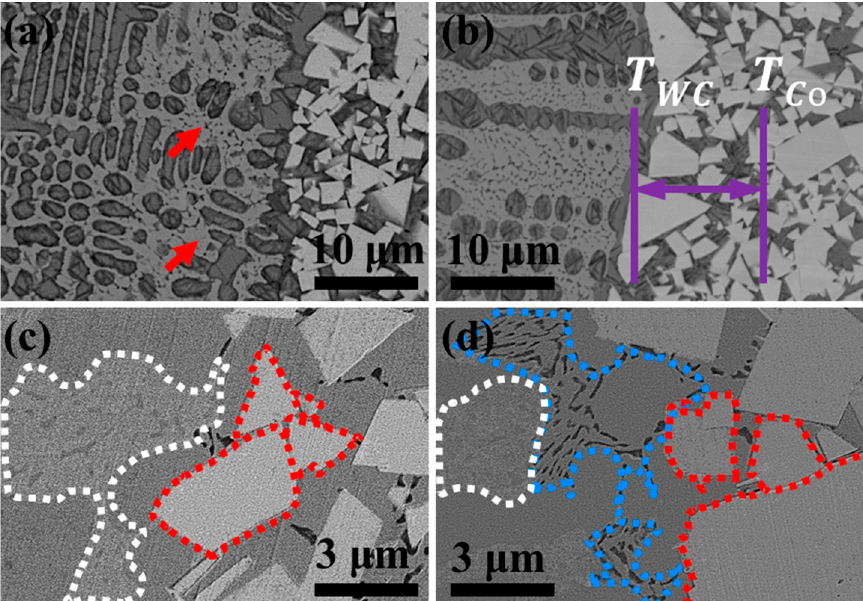
Figure 3. Laser welding of WC–Co cemented carbide and S45C carbon steel without filler metals. ( a ) Microstructures in a fusion boundary region. The red arrows show the mixed carbides. ( b ) The higher temperature border (T wc ) and lower temperature border (T Co ) of the fusion boundary region. ( c ), ( d ) Microstructures and grain growth in a fusion boundary region.